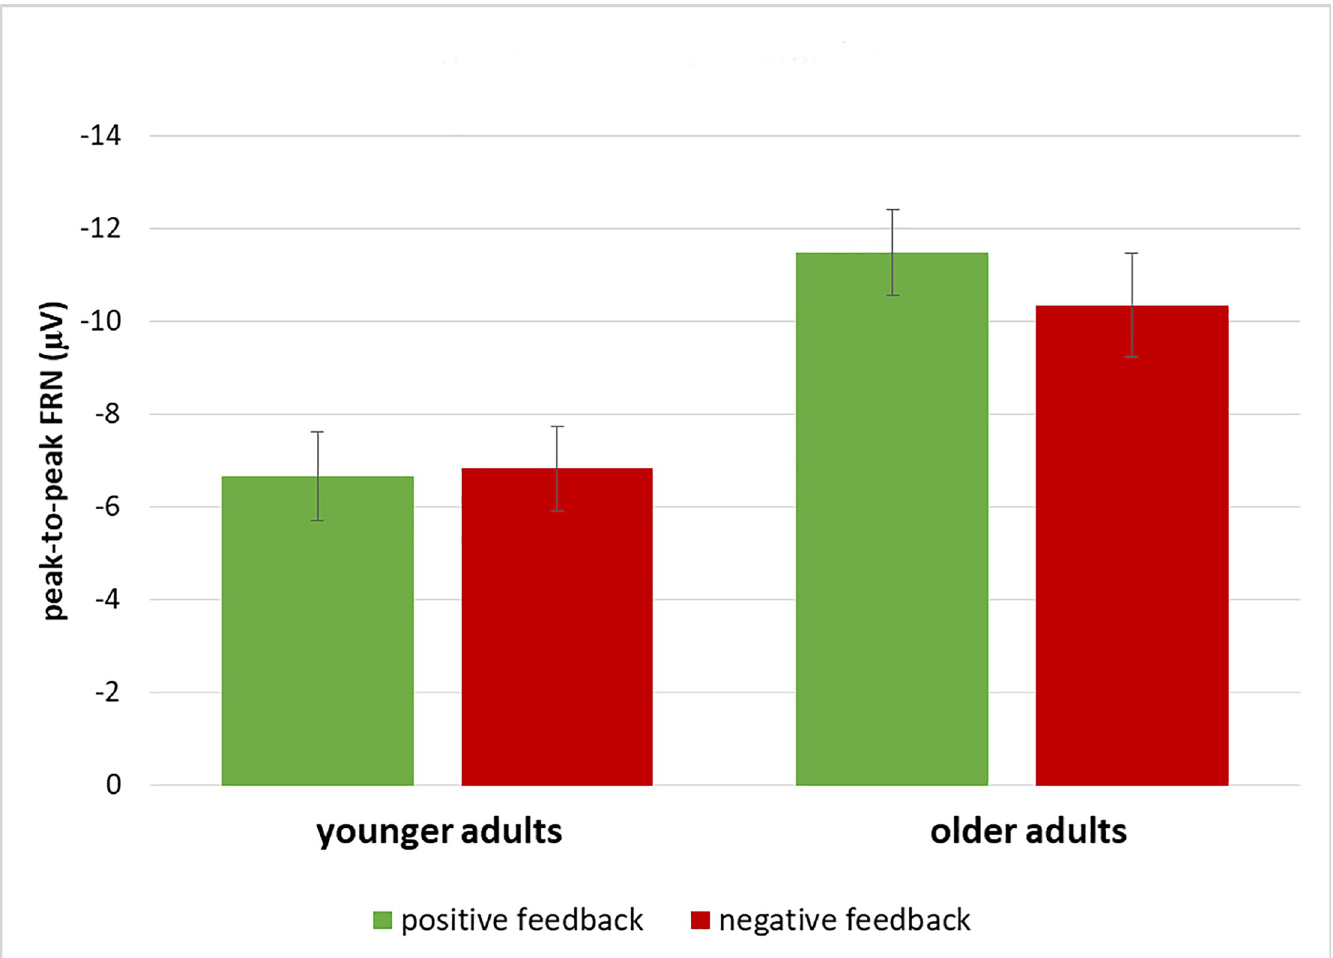
Fig 3. Illustration of the interaction between age and feedback valence in the peak-to-peak FRN (whiskers denote standard errors of the mean).